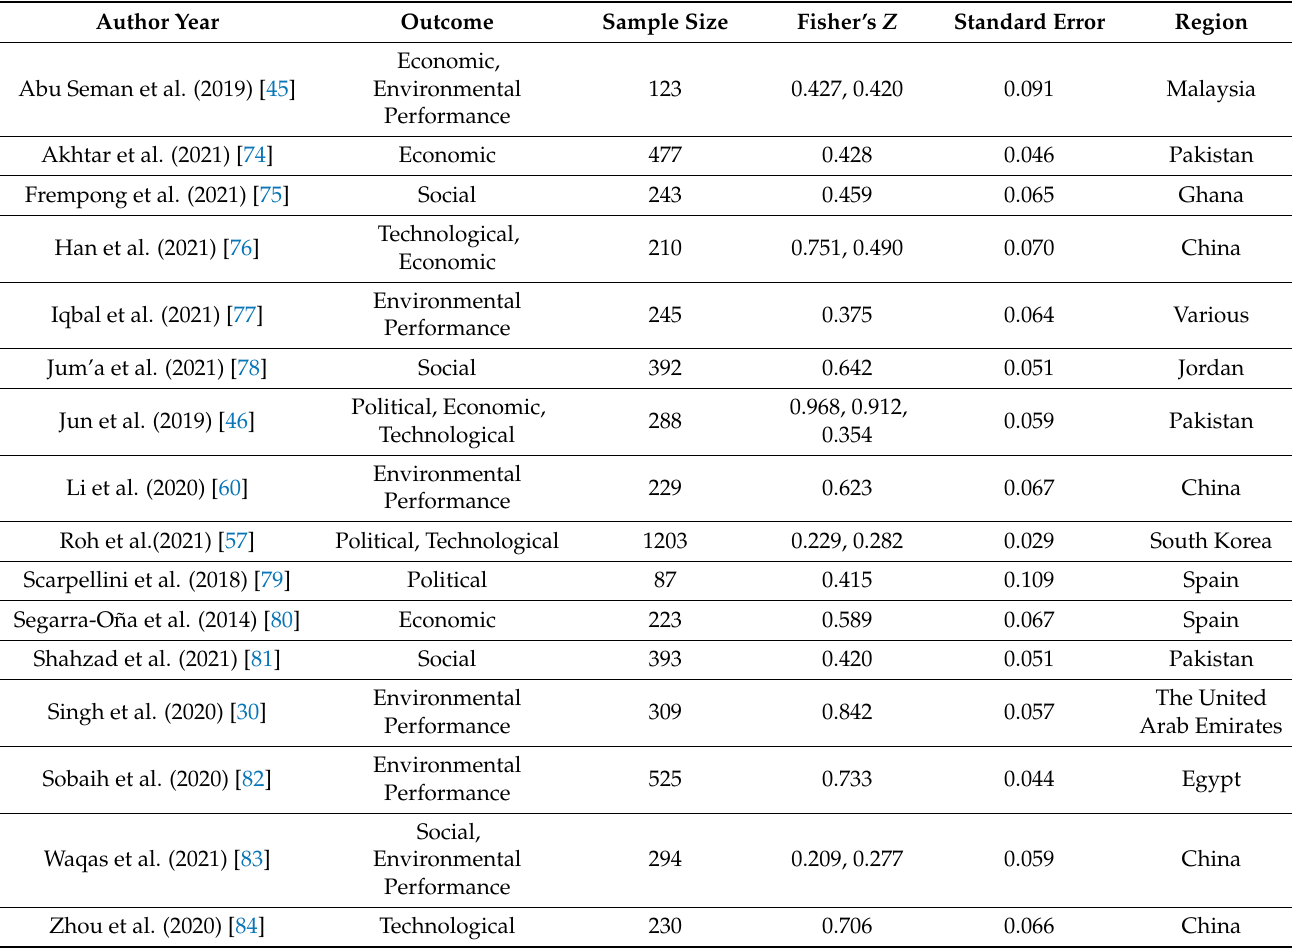
Table 2. Target literature code